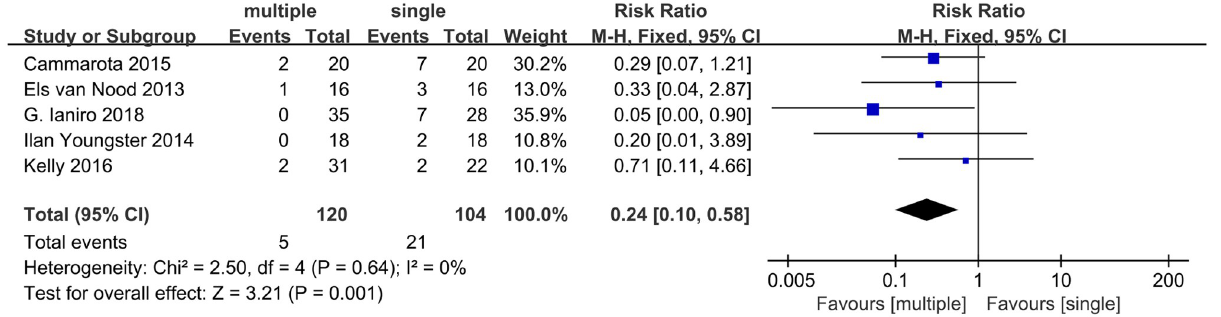
Fig 4. Subgroup analysis regarding the multiple infusions and single infusion of FMT for